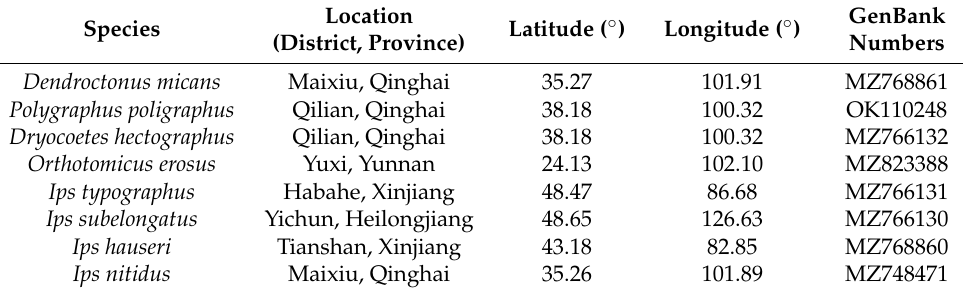
Table 1. Sampling information for eight bark